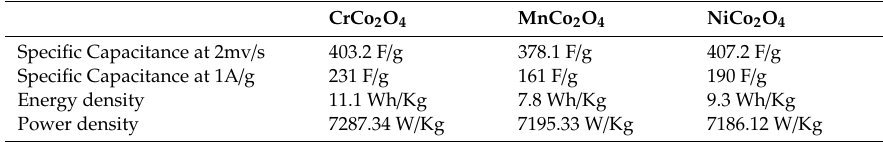
Table 3. Data of specific capacitance, energy density, and power density for MCo 2 O 4 (M = Cr, Mn, Ni) obtained from cyclic voltammetry and charge-discharge